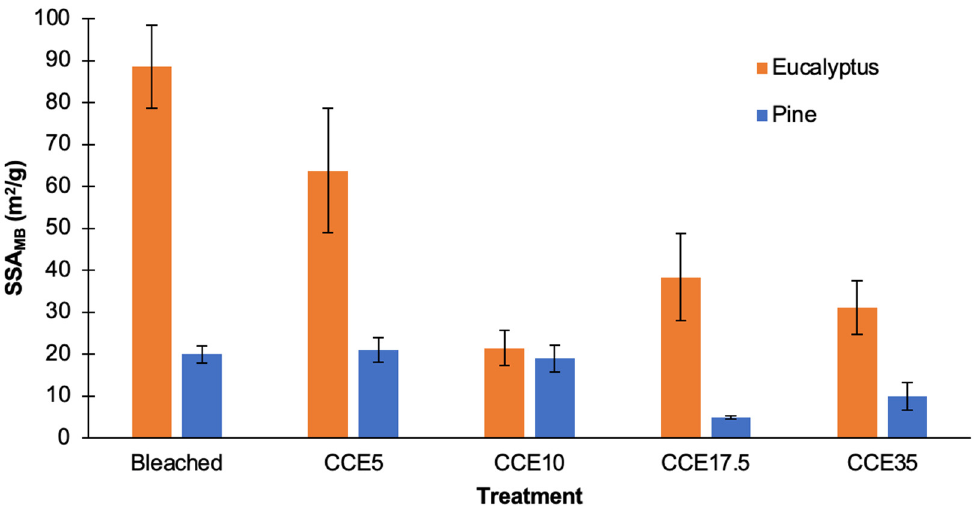
Figure 2. Specific surface area from MB adsorption (SSA MB ) of bleached and CCE-treated kraft pulps from eucalyptus and pine.